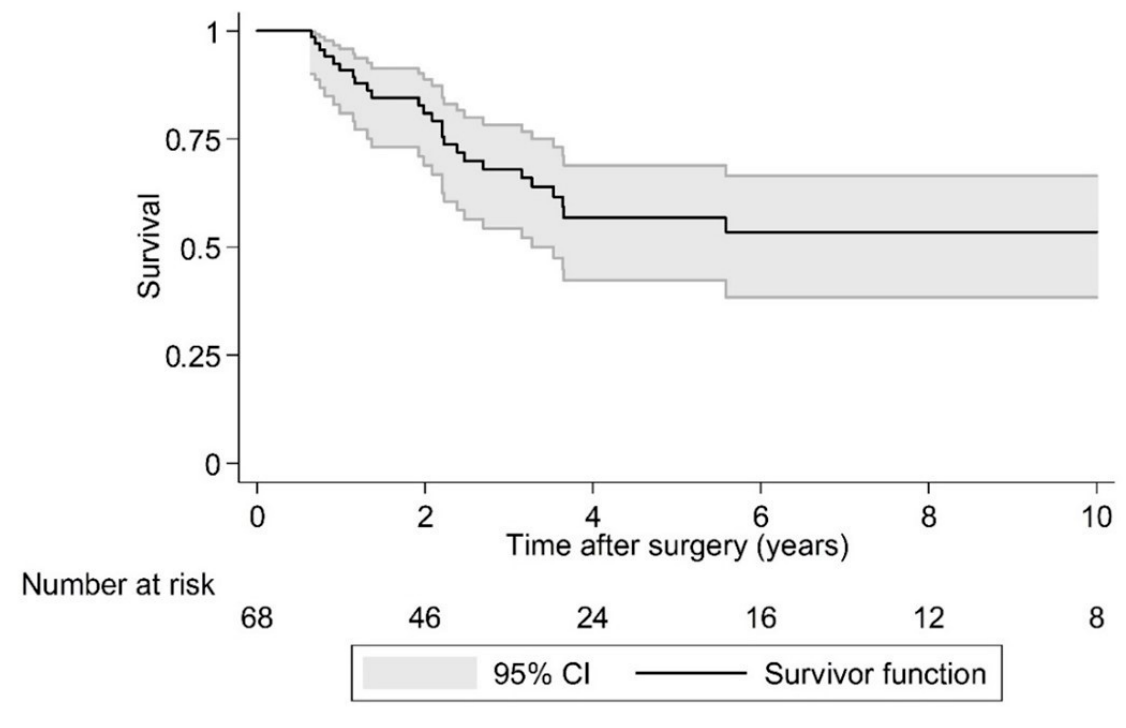
Figure 4. Kaplan-Meier analysis of overall survival.